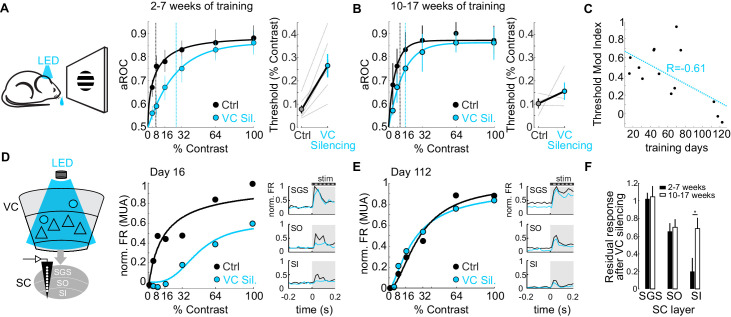
The impact of the cortico-tectal neurons diminishes with training.(A) Left: Schematic illustration of acute optogenetic silencing of VC in a behaving animal. Middle: Psychometric function of aROC against stimulus contrast of mice trained between 16 and 45 days under control conditions (black) and VC silencing (light blue; N = 6 mice). Data plotted as mean ± SEM. Dashed lines indicate the contrast detection threshold based on the Weibull function fit. Right: Contrast detection threshold of individual mice under control and during VC silencing (data plotted as mean ± SEM, N = 6 mice). (B) Left: As in A but for a separate group of mice trained between 70 and 131 days. Data plotted as mean ± SEM. Right: Contrast detection threshold of individual mice under control and during VC silencing (data plotted as mean ± SEM, N = 4 mice). Note that in these animals, VC silencing leads to a smaller rightward shift of the contrast detection threshold as compared to the animals with less training shown in (A). (C) Change in detection threshold upon VC silencing (reported as modulation index; see Materials and methods) plotted against training days. Each dot represents an individual animal. Dotted line: linear fit. Note inverse correlation between change in detection threshold and training days. (D) Left: Schematic illustration of extracellular recording in SC during behavior upon silencing of VC (stratum griseum superficiale (SGS); stratum opticum (SO); stratum griseum intermediale (SI)). Middle: Example mouse after 16 days of training. Contrast response function of multi-unit activity (MUA) in visual layers of SC under control conditions (black) and during VC silencing (light blue) during the performance of the detection task. Right: Peristimulus time histogram (PSTH) of MUA across depth in SC under control conditions (black) and during VC silencing (light blue; top: SGS; middle: SO; bottom: SO-SI). The shaded area is the period of stimulus presentation. Note the stronger effect of VC silencing on SI activity as compared to SGS. (E) As in (D) but for an example mouse after 112 days of training. (F) Population average of normalized evoked activity as a function of depth in SC. Black: early group (2–7 weeks of training), White: late group (10–17 weeks of training). Data plotted as mean ± SEM (early: N = 6 mice, late: N = 4 mice; p<0.05 Wilcoxon signed-rank test). Note that with prolonged training the impact of VC silencing on SI activity is strongly reduced.Figure 6—source data 1.Measurements of the cortical impact on psychometric data as a function of prolonged training and on neuronal activity in the Superior Colliculus.